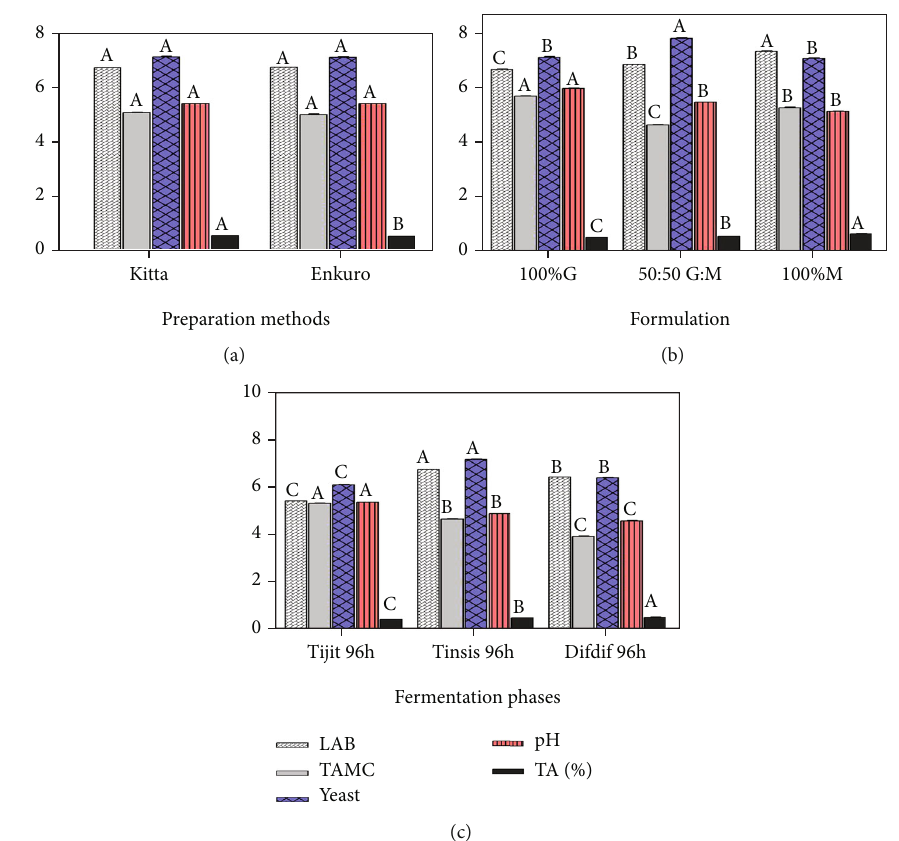
Figure 2: Biochemical properties of tella for di ff erent preparations (a), formulations (b) and fermentation phases (c); LAB: lactic acid bacteria; TAMC: total aerobic mesophilic count; TA: titratable acidity; G: gesho; M: moringa; values are least square means with standard error as error bars and bars with di ff erent letters are signi fi cantly di ff erent ( p < 0 : 05